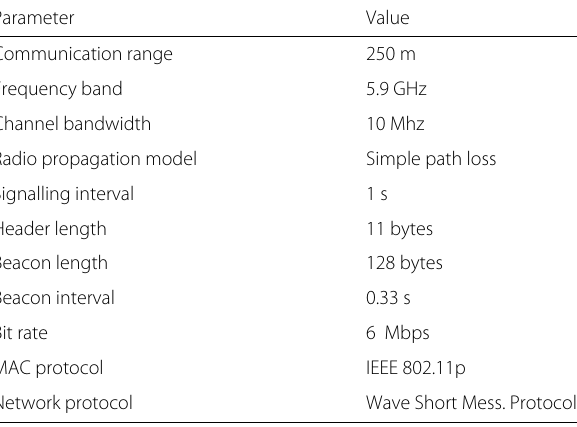
Table 6 Veins configuration